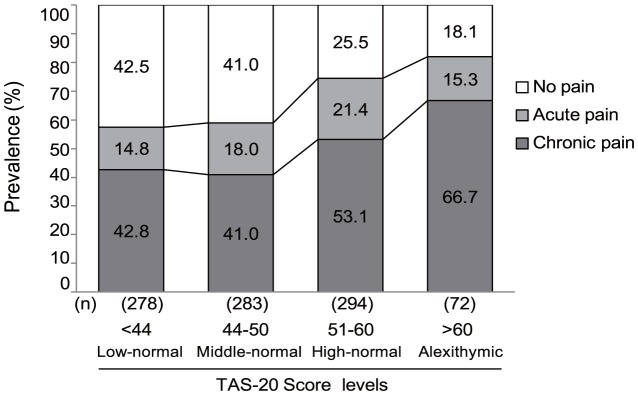
Self-reported pain prevalence according to the TAS-20 score levels in a general population from the Hisayama Study health survey.Acute pain: <6 months of pain. Chronic pain: pain that had been experienced for 6 months or longer.